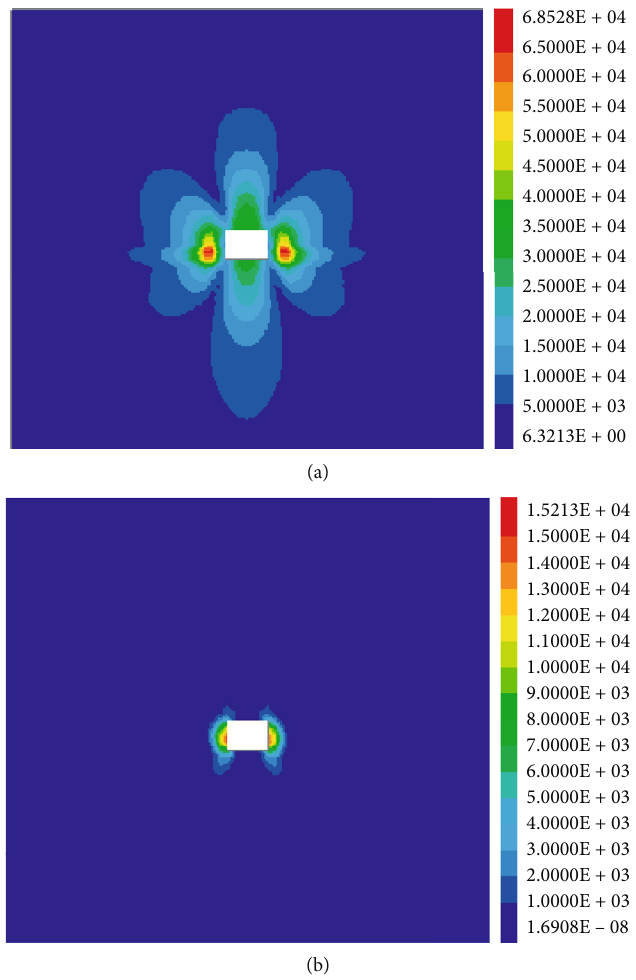
Figure 10: Energy density nephogram of roadway surrounding rock. (a) Elastic strain energy. (b) Plastic strain